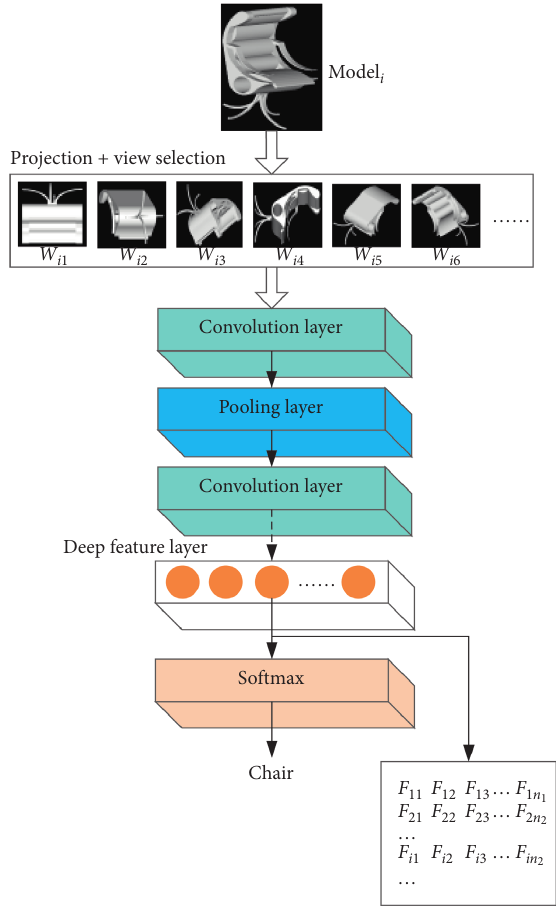
Figure 6: Index building process.